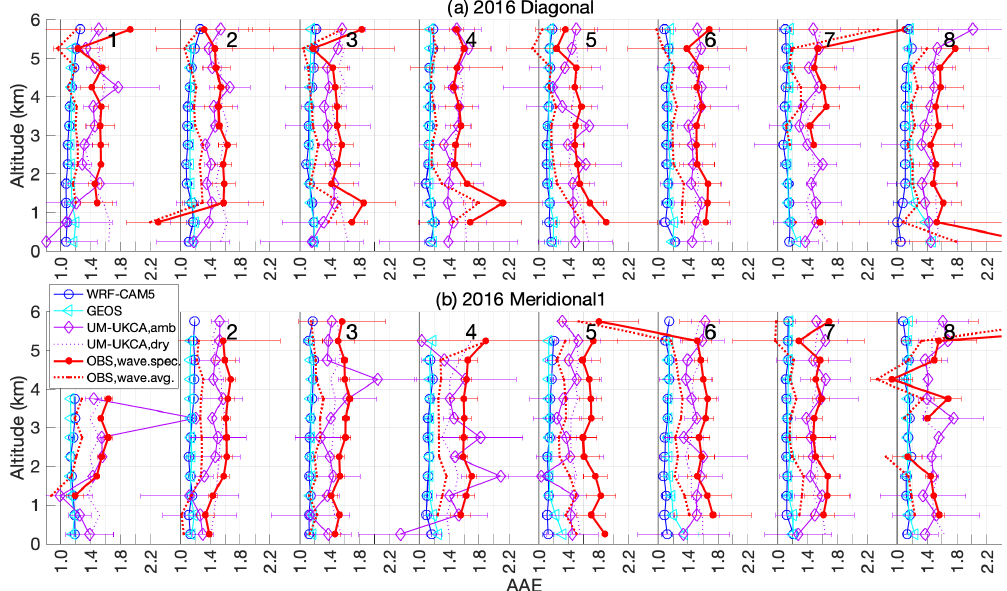
Figure 21. As in Fig. 16 but for the absorption Ångström exponent (AAE). Observed values of AAE are given for both the wavelength- specific and wavelength-averaged correction factors.